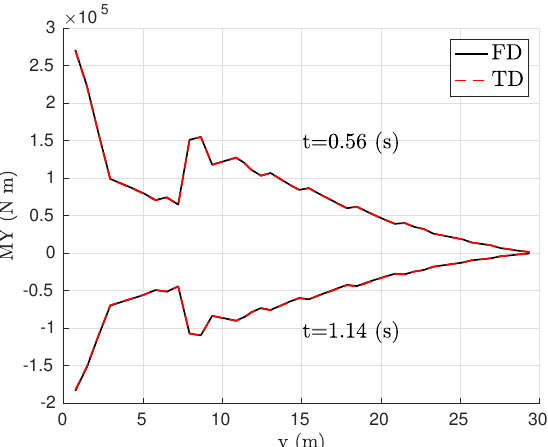
Figure 13. Incremental torsional moment MY over the right wing component at different time instants for M ∞ = 0.85, h = 7640 (m), H = 106.68 (m) and α eq = 1 (deg). Two rigid-body modes and one flexible mode considered. Results obtained by the FSM with the generalized state-space model in the time domain (TD) of 81 states compared to the reference model in the frequency domain (FD).